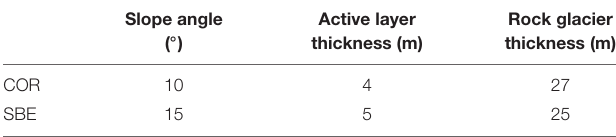
TABLE 2 | Material Rock glacier thickness (m)